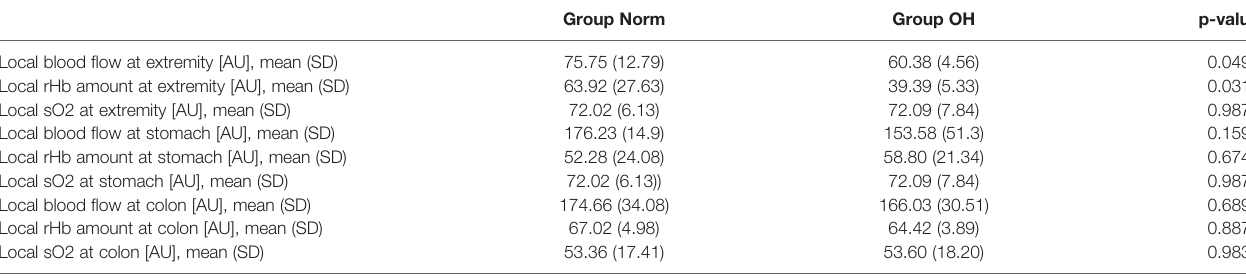
TABLE 2 | Occult hypoperfusion is associated with reduced local circulation in injured soft tissue 6 hours after trauma.